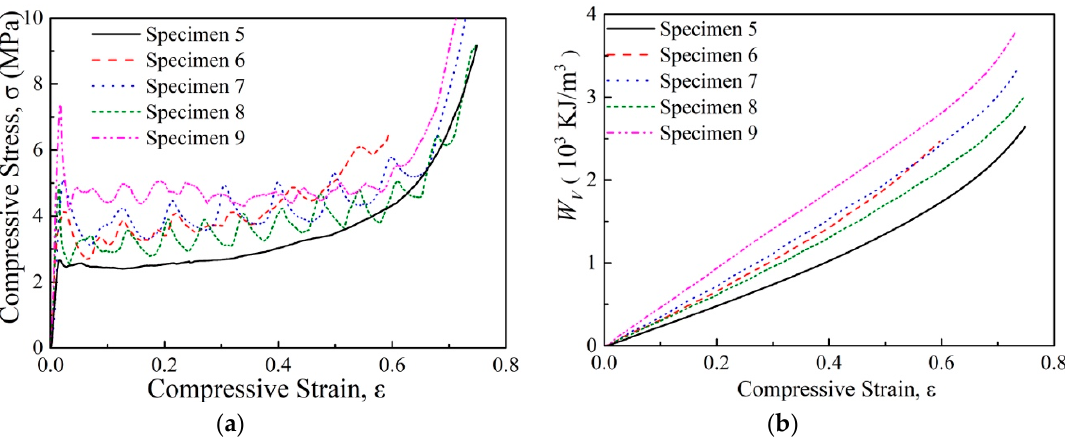
Figure 6. Compressive behaviors of tube-enhanced absorbent PMI foams. ( a ) Typical stress–strain curves; ( b ) Energy absorption per volume.